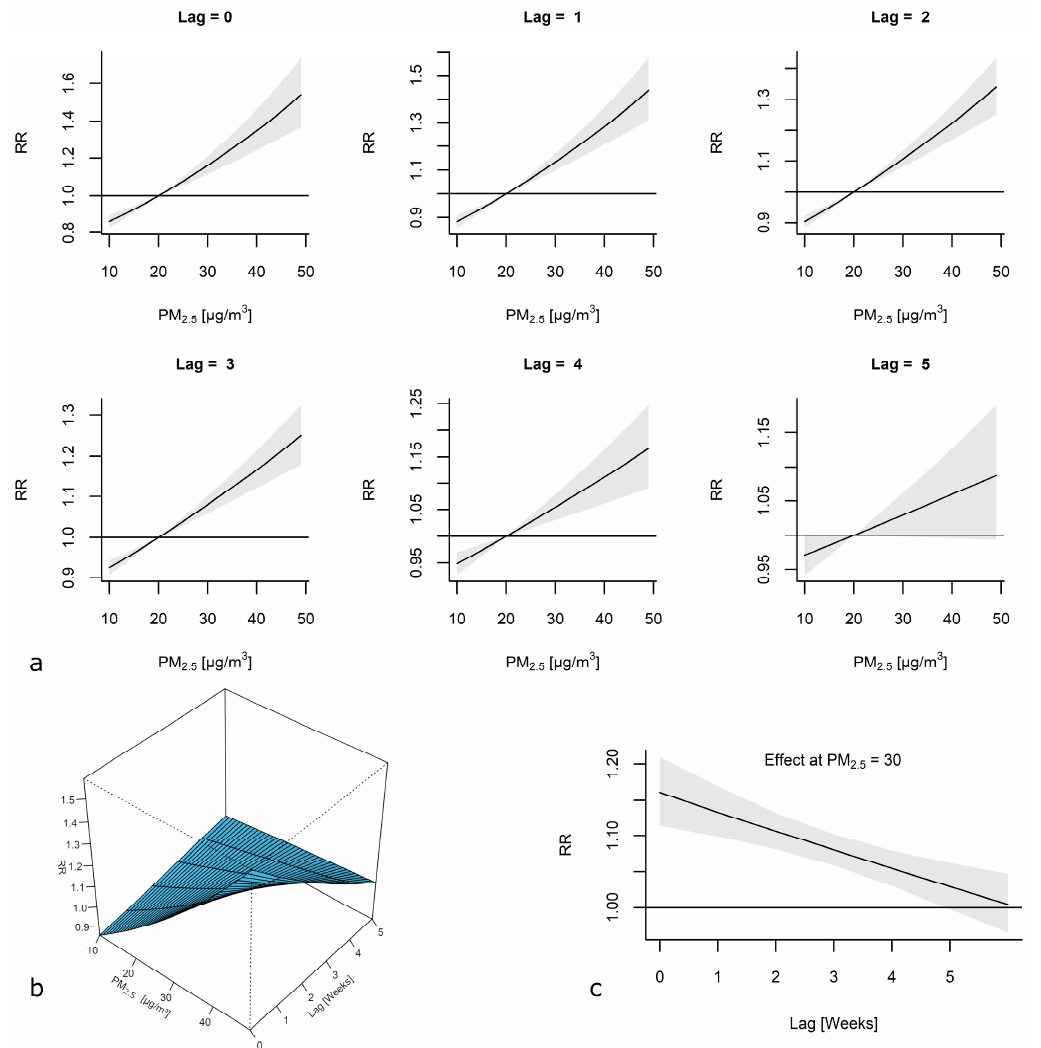
Figure 4. ( a ) The association between the concentration of PM 2.5 and the relative risk (RR) of the incidence of influenza-like illness (ILI) is depicted as the estimated exposure–response curves for lags of 0 to 5 weeks with 95% confidence intervals (CIs). ( b ) The association between the concentration of PM 2.5 and the RR of the incidence of ILI is depicted as the estimated exposure-lag-response surface. The model was adjusted for the mean air temperature and a long-term trend. ( c ) The estimated lag–response curve for PM 2.5 = 30 μ g/m 3 with 95% CI.